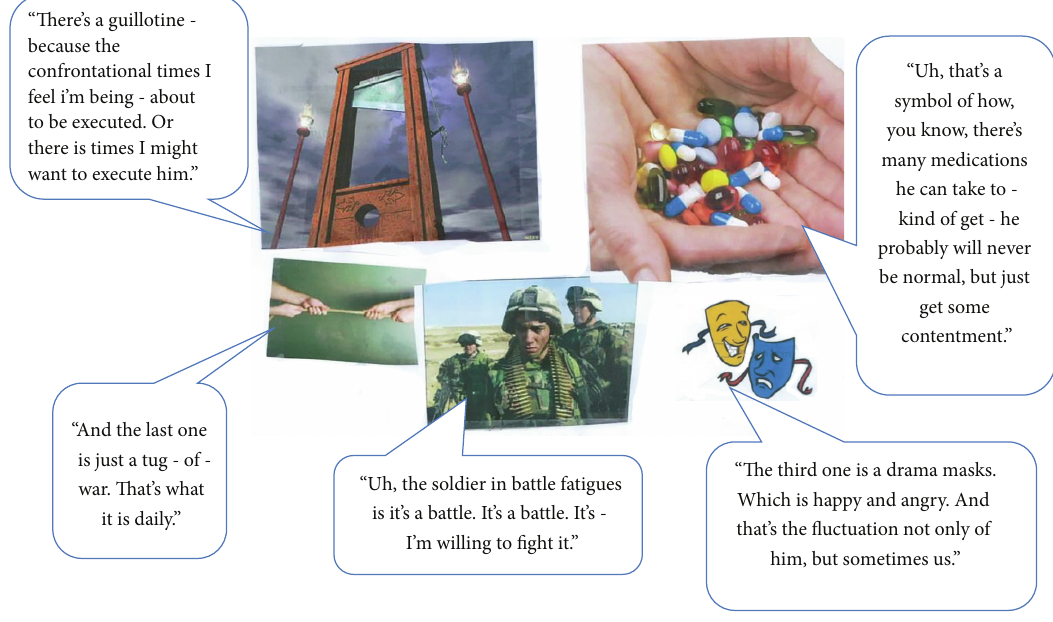
Figure 2: Caregiver ID: